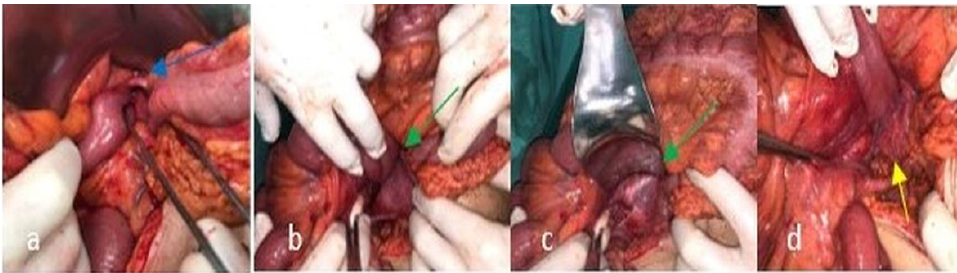
Figure 3. Perioperative findings: ( a ) small intestine loops on the right of Treitz’s ligament (blue arrow). ( b , c ). The orifice of the hernia (green arrow). ( d ) Repositioned hernia and closure of the gap (yellow arrow).